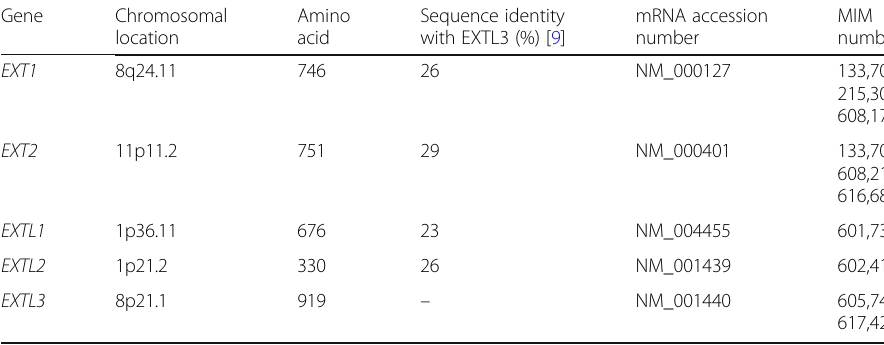
Table 1 Human EXT family Gene Chromosomal location